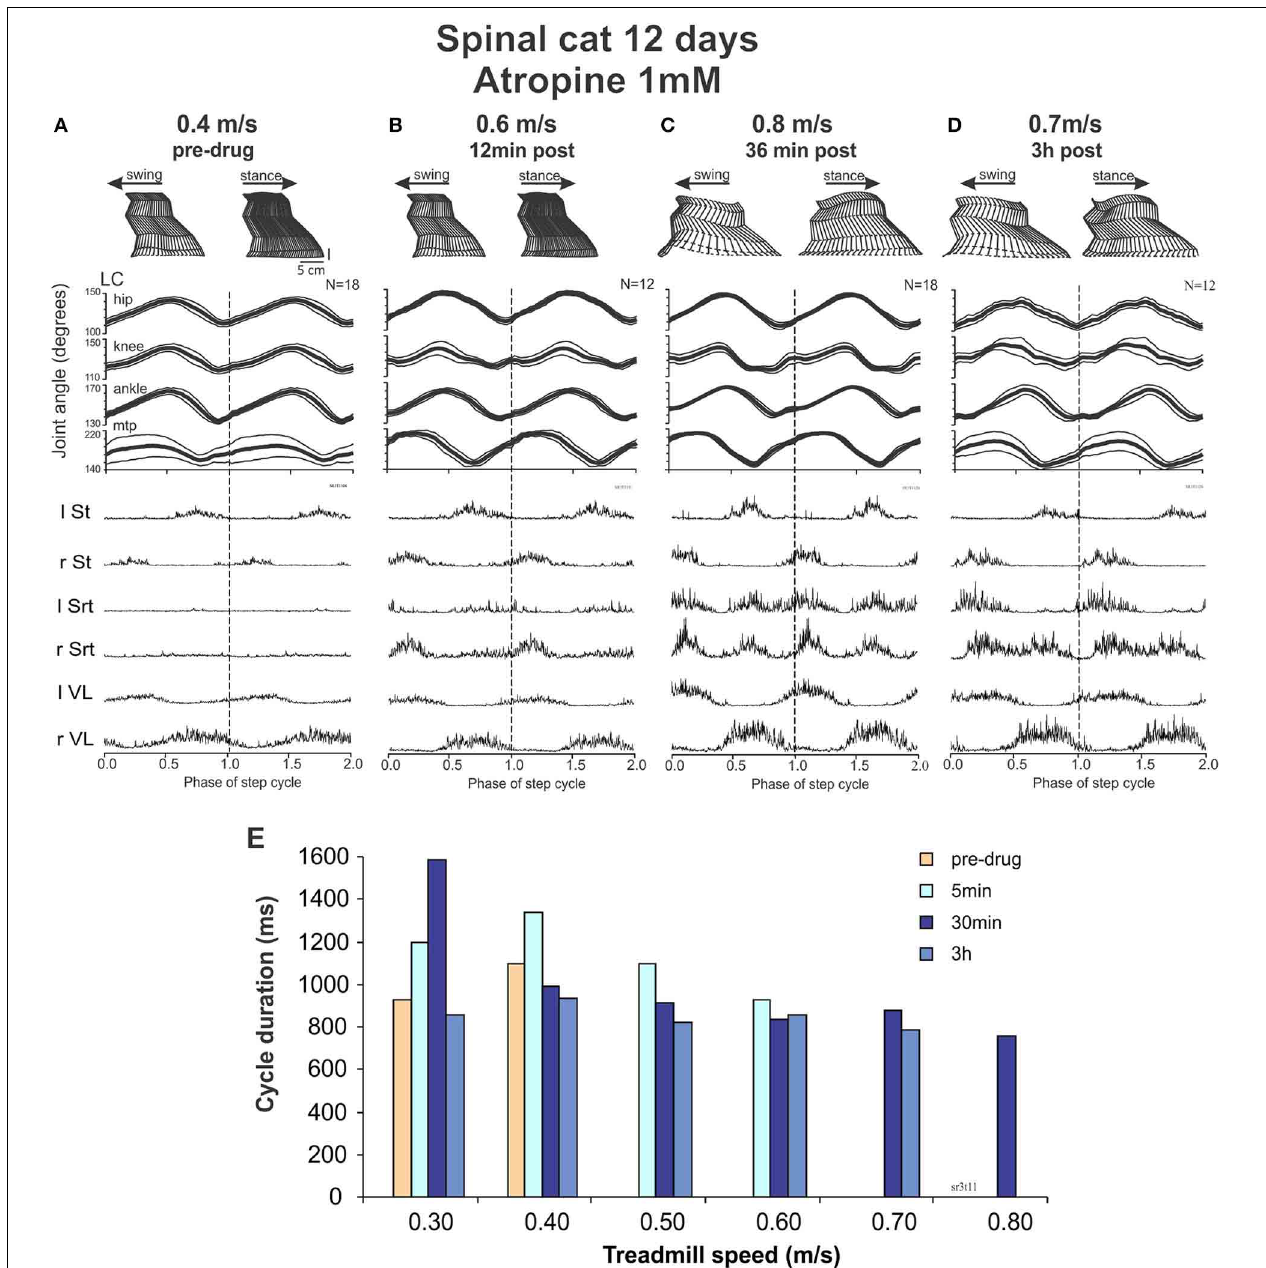
FIGURE 8 | Intrathecal atropine facilitated locomotion in spinal cats. (A–D) show kinematic and EMG recordings of a cat walking on a treadmill at increasing time after atropine (1mM, 100 μ l) administration: stick figures of one step cycle (top), averaged angular excursion of the four joints over N > 12 step cycles (middle) and corresponding averaged rectified EMG traces (bottom). The cycle is normalized to 1 and is repeated twice (separated by doted vertical lines) for clarity at turning points. The average is